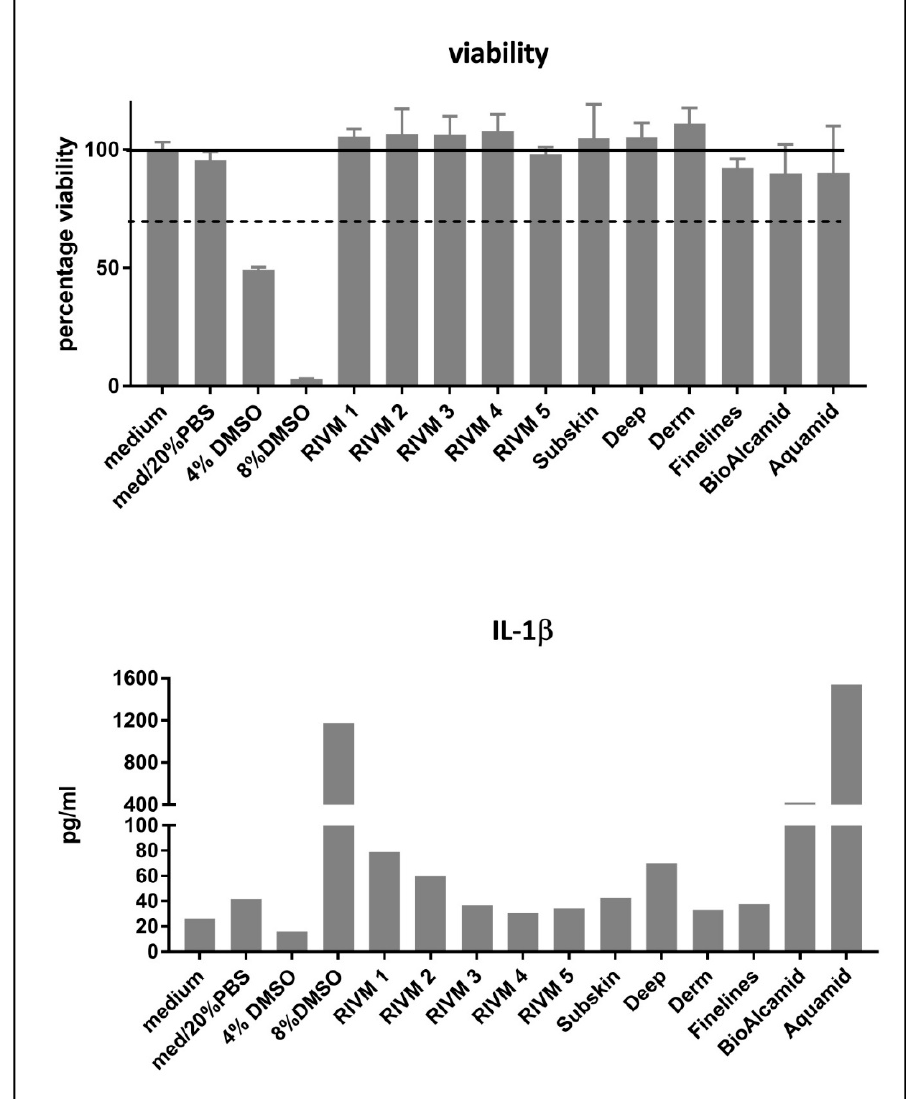
Figure 1. Effect of RIVM and Perfectha ® (Subskin, Deep, Derm, Finelines) HA fillers, and DMSO on cell viability. Results are presented as mean ± SD of three independent experiments while in each experiment, incubations were performed in four-fold. Top: Viability of THP-1-derived macrophages after 24 h exposure to various HA filler extracts. The 70% cell viability is indicated as the level for the indication of cytotoxicity (ISO 10993-5:2009). Bottom: IL-1 β production by THP-1-derived macrophages after exposure to various HA filler extracts. RIVM preparations #1–#5 have an increase in cross-linking of HA chains by BDDE from #1 to #5. Perfectha ® fillers have a decrease in particle size from Perfectha ® SubSkin to Perfectha ®